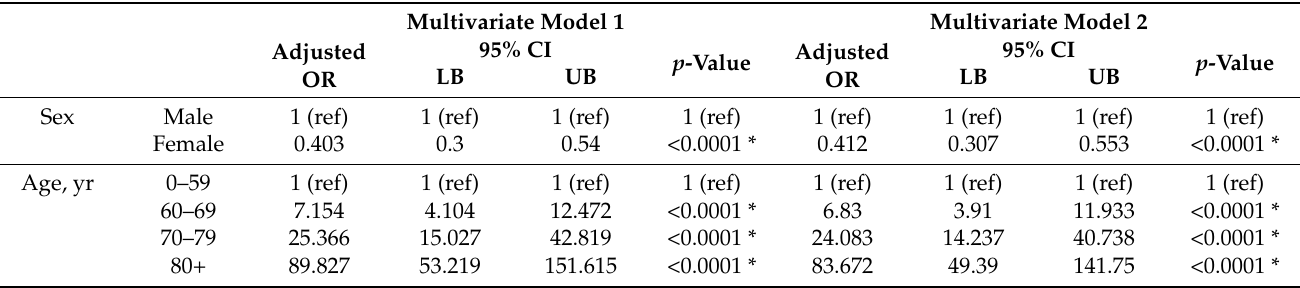
Table 4. Odds ratio for the risk of COVID-19